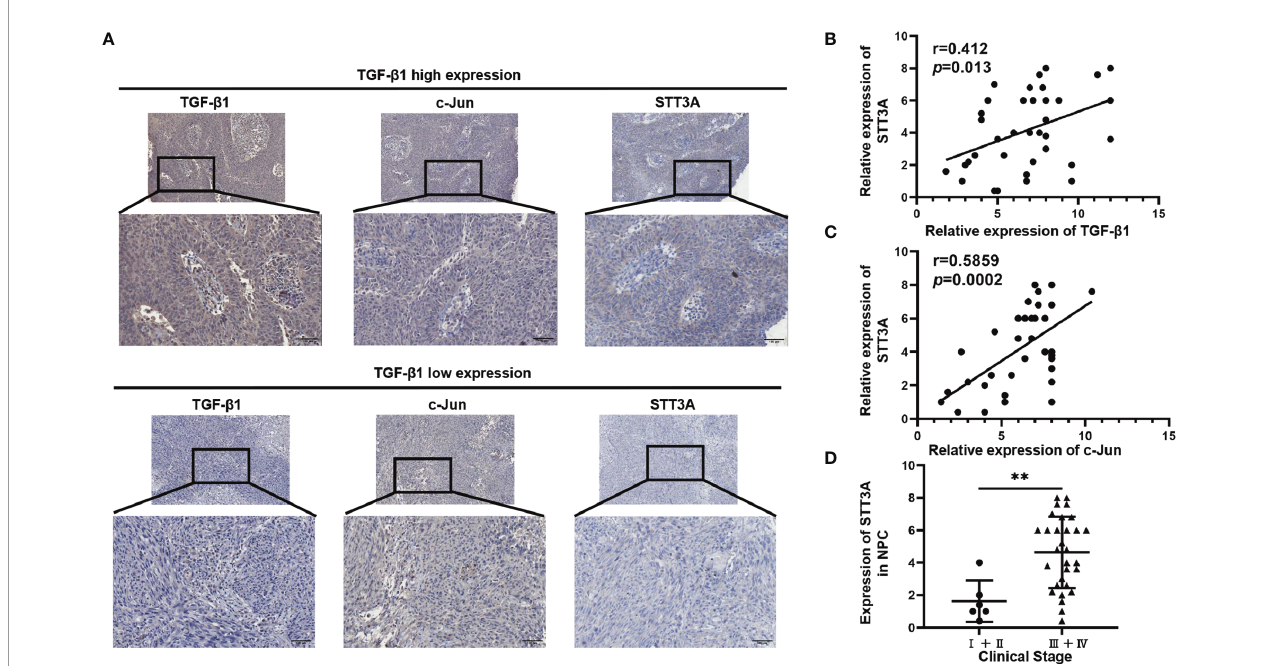
FIGURE 4 | STT3A Expression was Positively Correlated with TGF- b 1 and C-Jun in NPC Tissues, and High STT3A Expression was Associated with a more advanced stage in NPC. (A) Representative pictures of c-Jun and STT3A expression in NPC patients in TGF- b 1-low and high expression groups. Scale bars represented 100 m m. (B, C) Pearson correlation analysis of the association between TGF- b 1 and STT3A (r=0.412; p =0.013) and between c-Jun and STT3A (r=0.5859; p =0.0002) in NPC tissues. (D) Comparison of STT3A levels in 36 NPC patients with different clinical stages. ** p